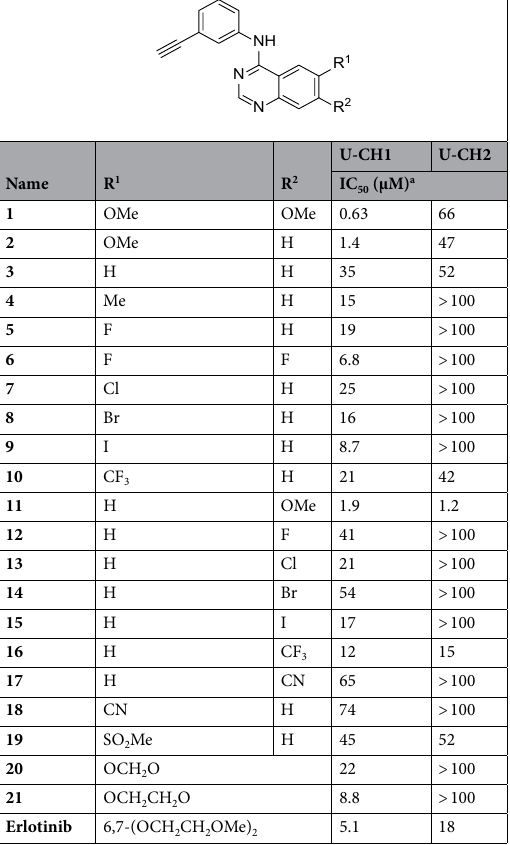
Table 1. Initial screening of quinazolines against chordoma cell lines. a Cell viability assay (n =